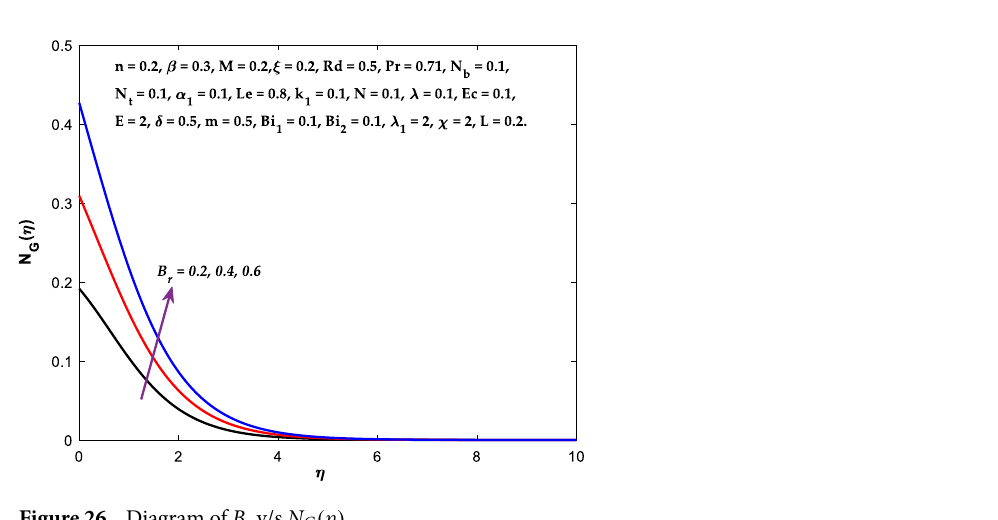
Figure 26. Diagram of B r v/s N G (η)